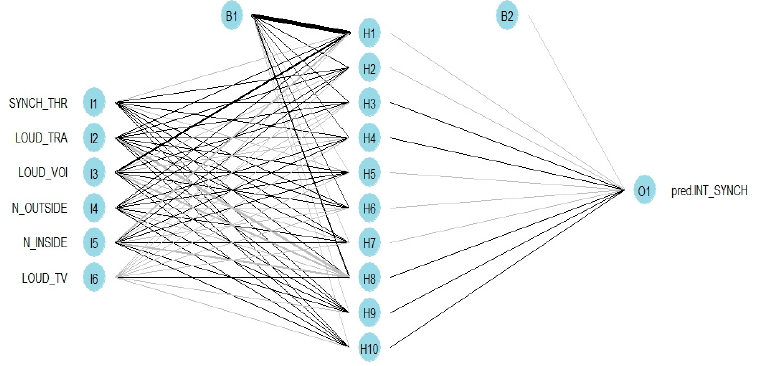
Figure 12. Artificial neural network representation of the model for the noise interference with syn- chronous activities. The black lines represent positive weights and the grey ones negative. Line thickness is the relative weight with respect to the other variables.